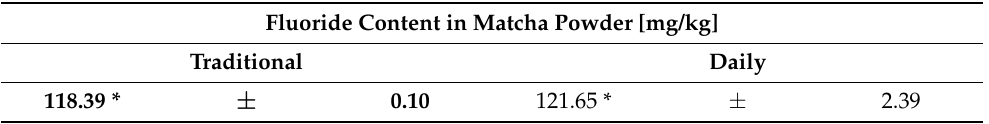
Table 1. The fluoride content in matcha powder (traditional, daily) * FDR p < 0.05 between the types of matcha powder (traditional, daily).